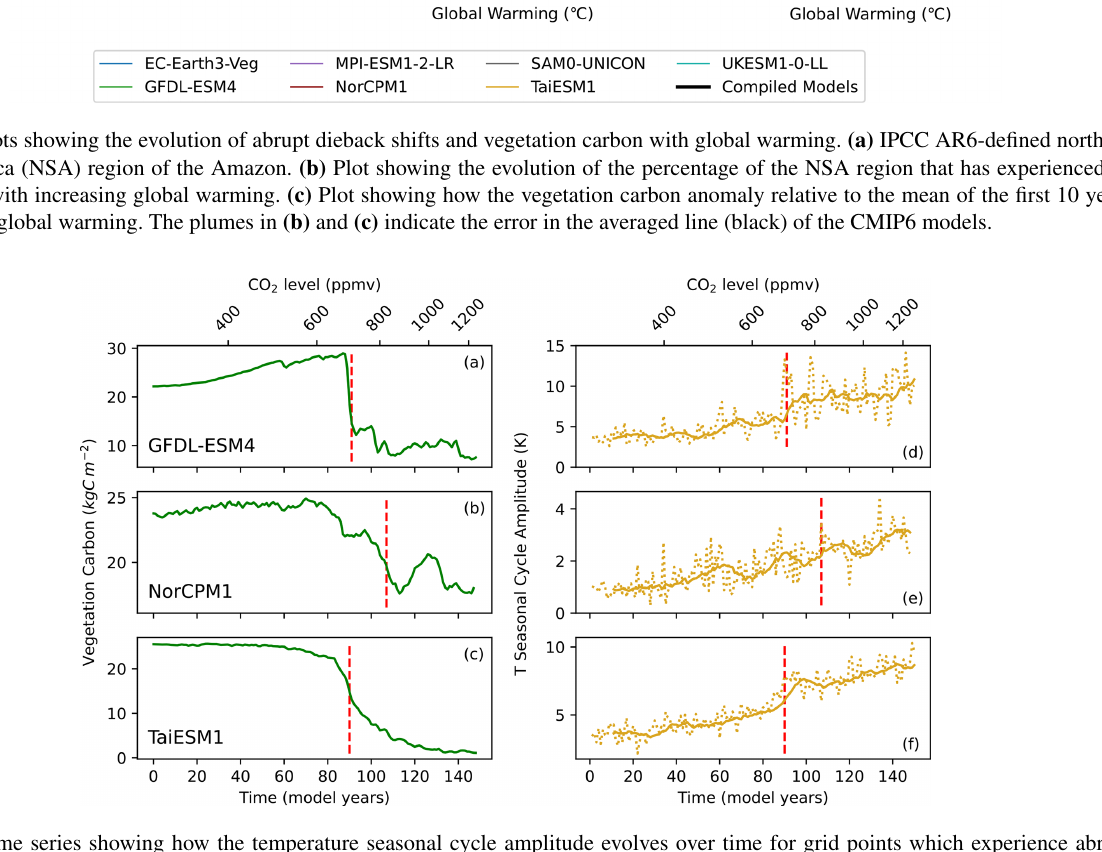
Figure 3. Time series showing how the temperature seasonal cycle amplitude evolves over time for grid points which experience abrupt dieback shifts. (a-c) Example time series of identified dieback shifts for three models at grid points 5 ◦ S, 65 ◦ W; 0 ◦ , 60 ◦ W; and 0 ◦ , 60 ◦ W. The dotted red line indicates the midpoint of the 15-year period where the abrupt shift is detected by the algorithm. (d–f) The change in the amplitude of the temperature seasonal cycle with time and CO 2 for these dieback shifts in each model. The solid lines represent the 10-year running average of the seasonal cycle amplitude, while the dotted lines are the yearly